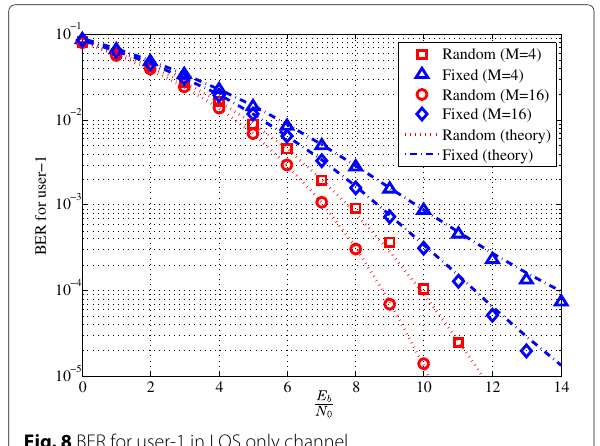
Fig. 8 BER for user-1 in LOS only channel